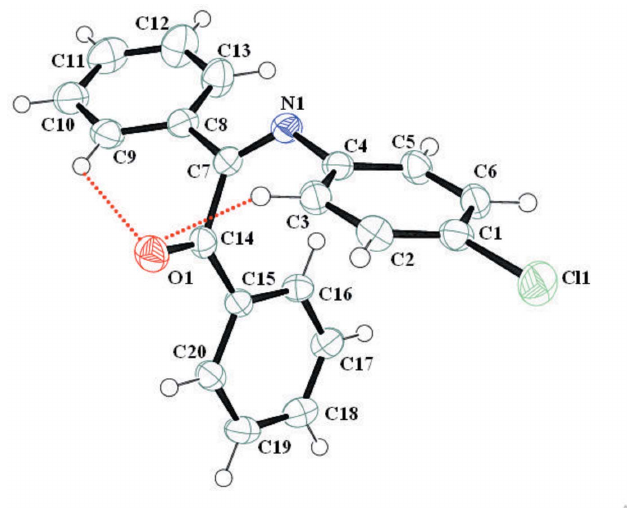
Figure 3 ( a ) View of part of the crystal structure, showing the formation of a hydrogen-bonded C18—H18 (cid:3)(cid:3)(cid:3) O1 chain and ( b ) the intermolecular C— H (cid:3)(cid:3)(cid:3) (cid:2) (ring) and (cid:2) – (cid:2) stacking interactions bonds (violet and blue dashed lines, respectively) in the ab plane.